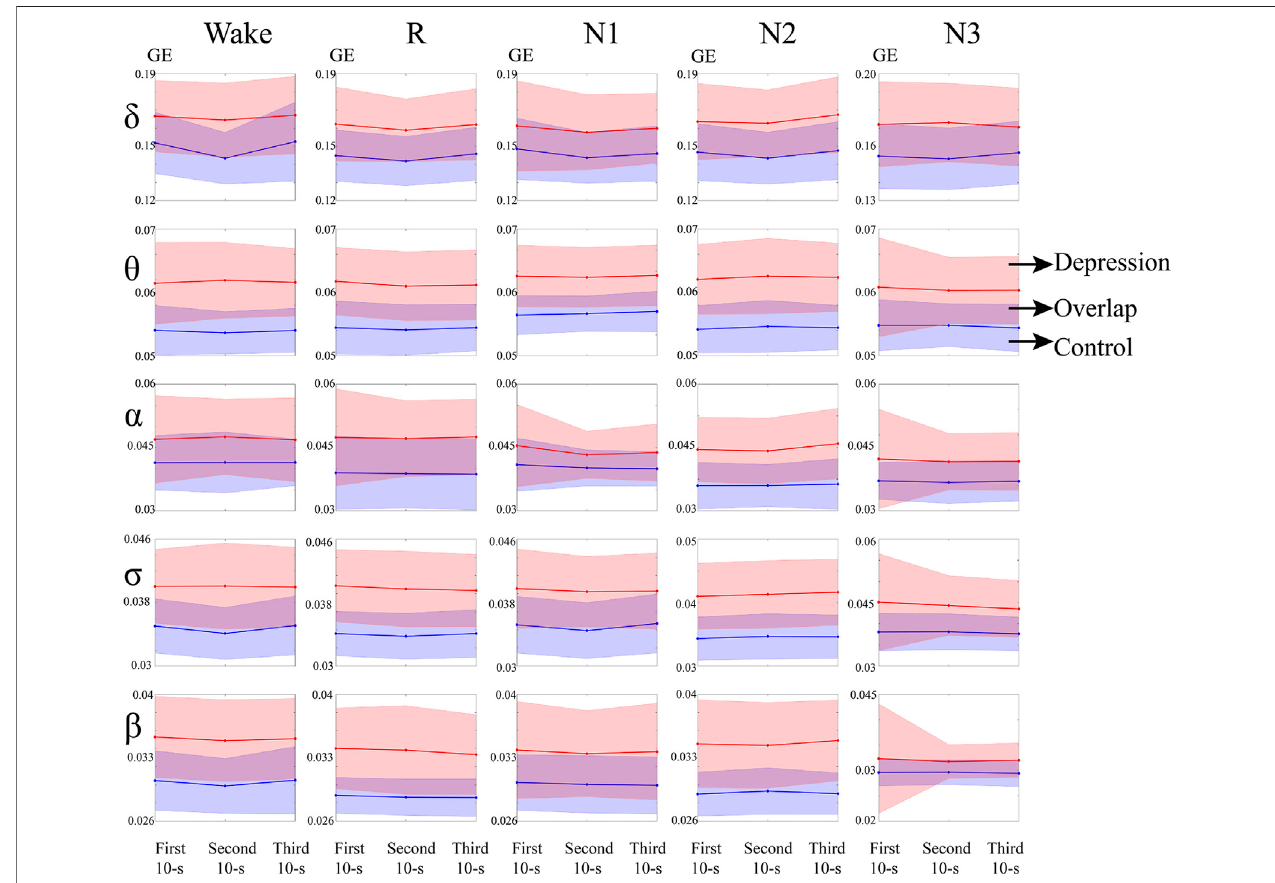
FIGURE3| GEofthedepressedandcontrolgroupsduringsleepswitching.Redandbluerepresentthedepressedgroupandcontrolgroup,respectively.Purpleis the overlapping part of the two groups.